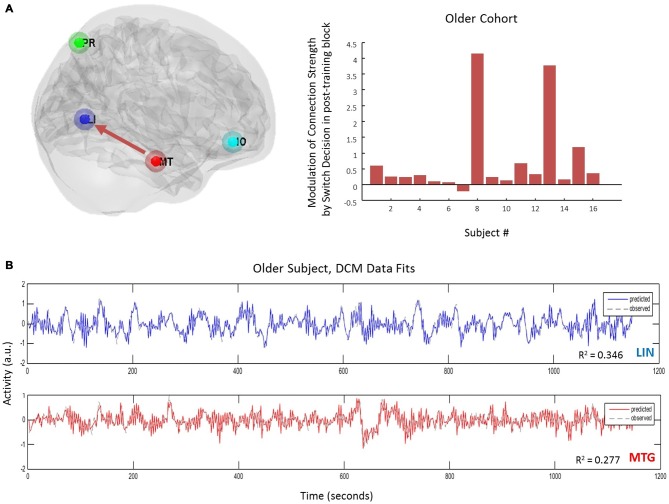
Age-effects on connectivity mediating volitional perception. (A) Only in the older cohort did we see pre-switch modulations of effective connectivity. Specifically we observed an emergence of a top-down control connection (MTG → LIN) following the bias or training block. (B) DCM fits here from one subject and displayed for two regions accurately recapitulate the extracted time-series.